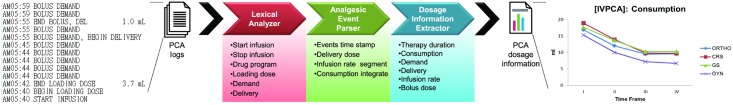
The flowchart of PCA DIG.